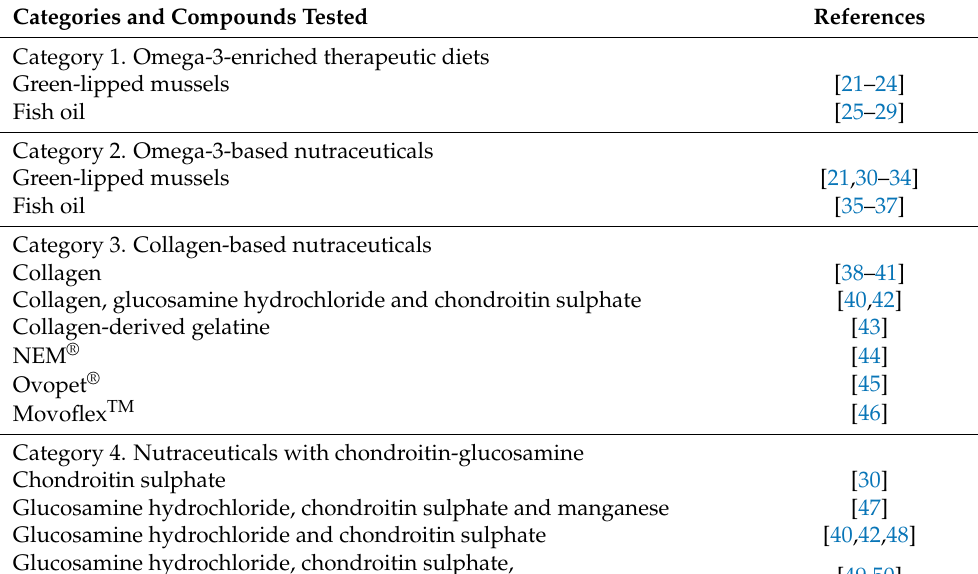
Table 2. Presentation, by category, of clinical trials on therapeutic nutrition and nutraceuticals in canine and feline